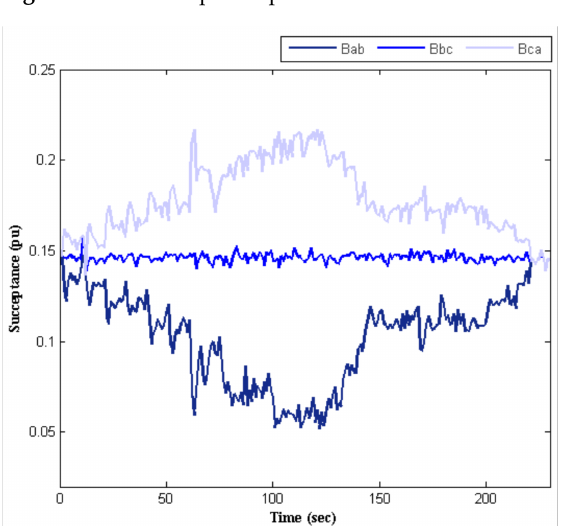
Figure 13. SVC’s succeptances profile based on the considered